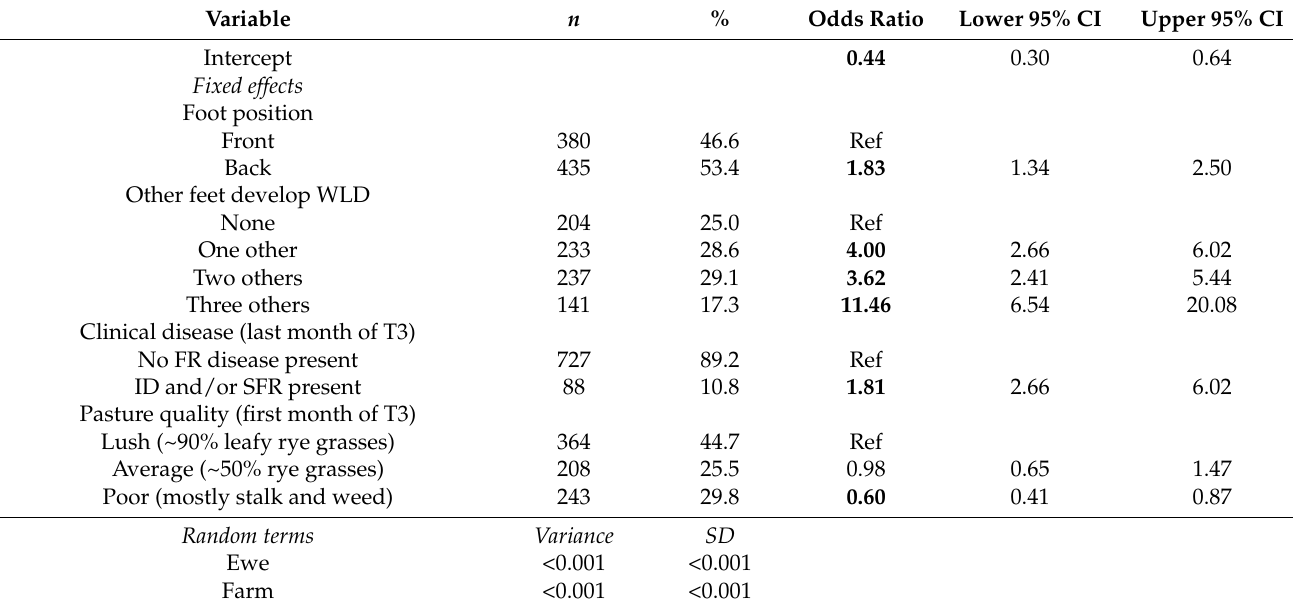
Table 15. Final multivariable model of the associations with the development of WLD at foot-level for 815 observations